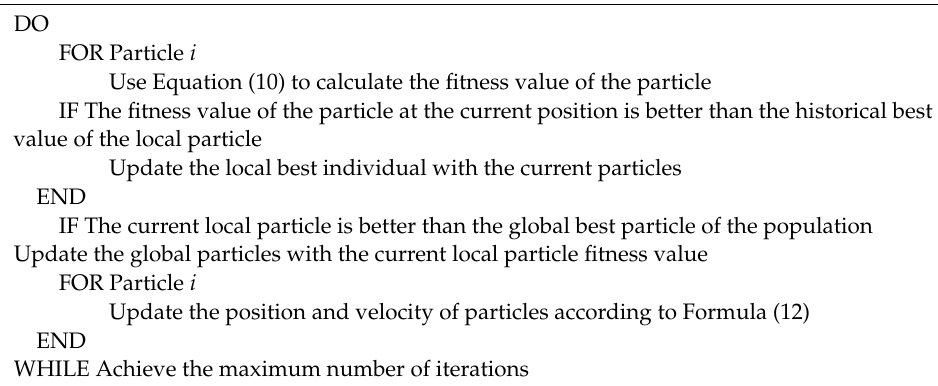
Algorithm 1 : Using FCFS algorithm, SJF algorithm, or MAX_MAX algorithm to initialize